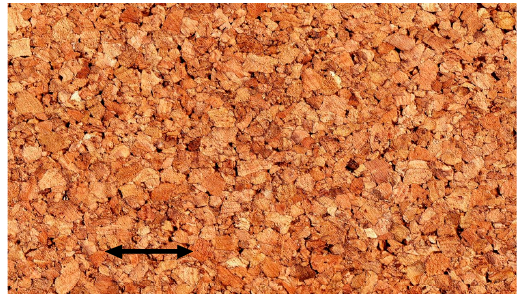
Figure 2. Cork granules with average diameter 2–3 mm (black unit 10 mm).